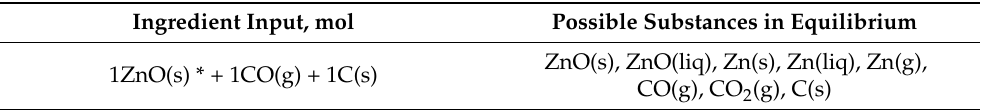
Table 1. Software setting for equilibrium calculations of ZnO reduction processes. Ingredient Input, mol